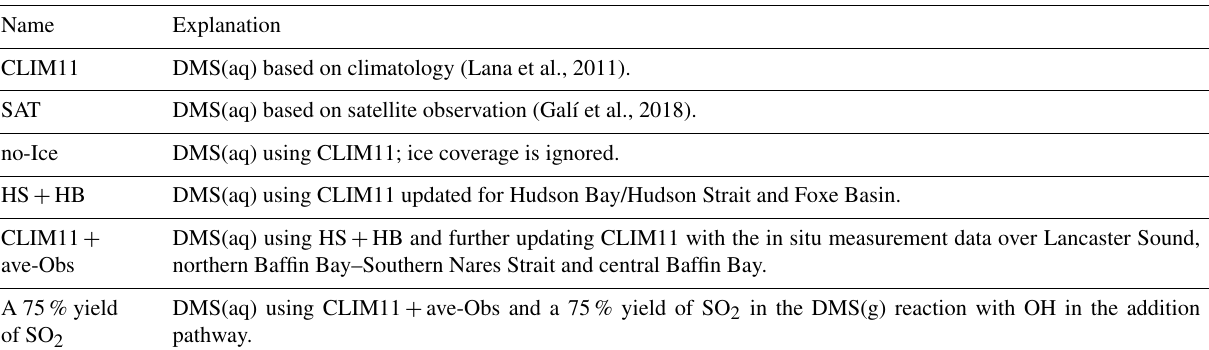
Figure 8. Sensitivity runs during July 2014: (a) no-Ice, (b) HB + HS and (c) CLIM11 + ave-Obs. Table 1. DMS(aq) data sets and sensitivity